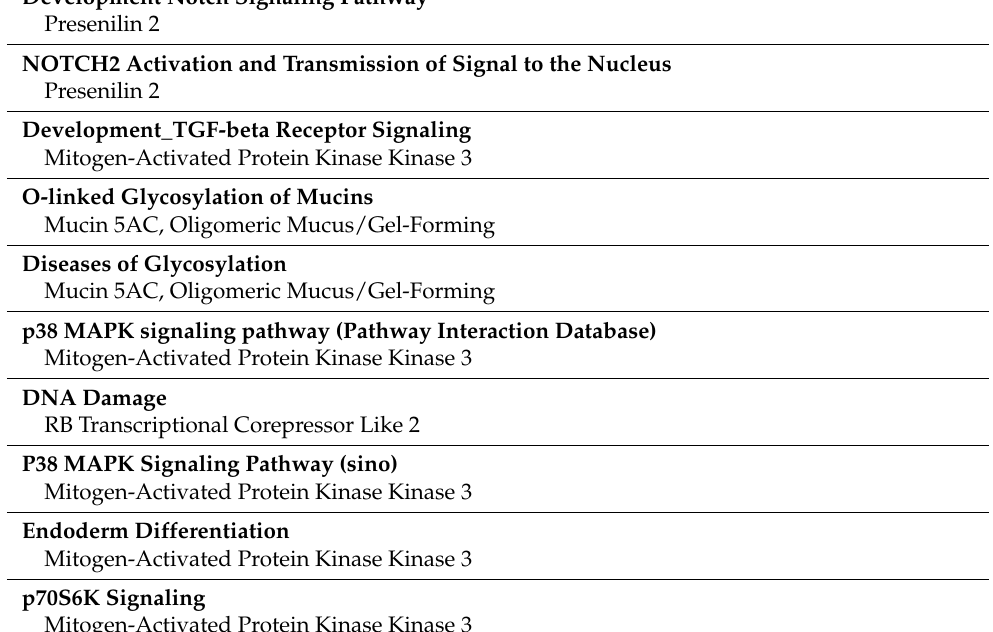
O-linked Glycosylation of Mucins Diseases of